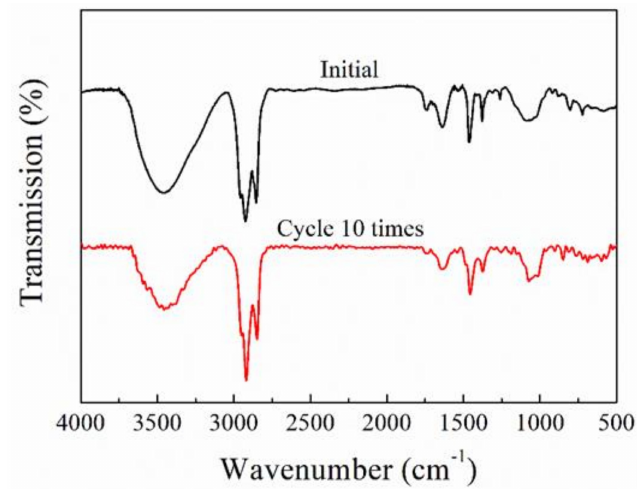
Figure 14. The FT-IR spectrum of the C-EC / TPU gel coating after 10 times of melting at 180 ◦